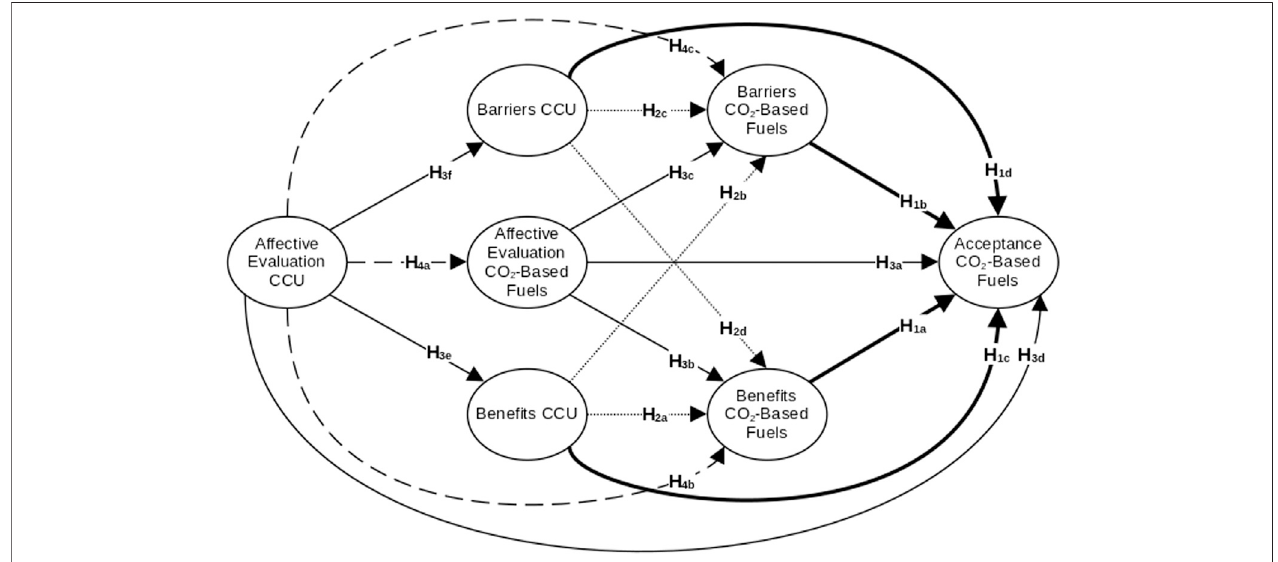
FIGURE 1 | Overview of hypotheses. The thick solid lines indicate the hypothesized direct relationships between perception and acceptance (H 1 ); the dotted lines indicate the hypothesized relationships between the perception of CCU and the perception of CO 2 -based fuels (H 2 ); the thin solid lines indicate the hypothesized relationships between the affective evaluations and perception and acceptance (H 3 ); and the long-dashed lines indicate the hypothesized relationships between the affective evaluation of CCU and the evaluation and perception of CO 2 -based fuels (H 4 ).